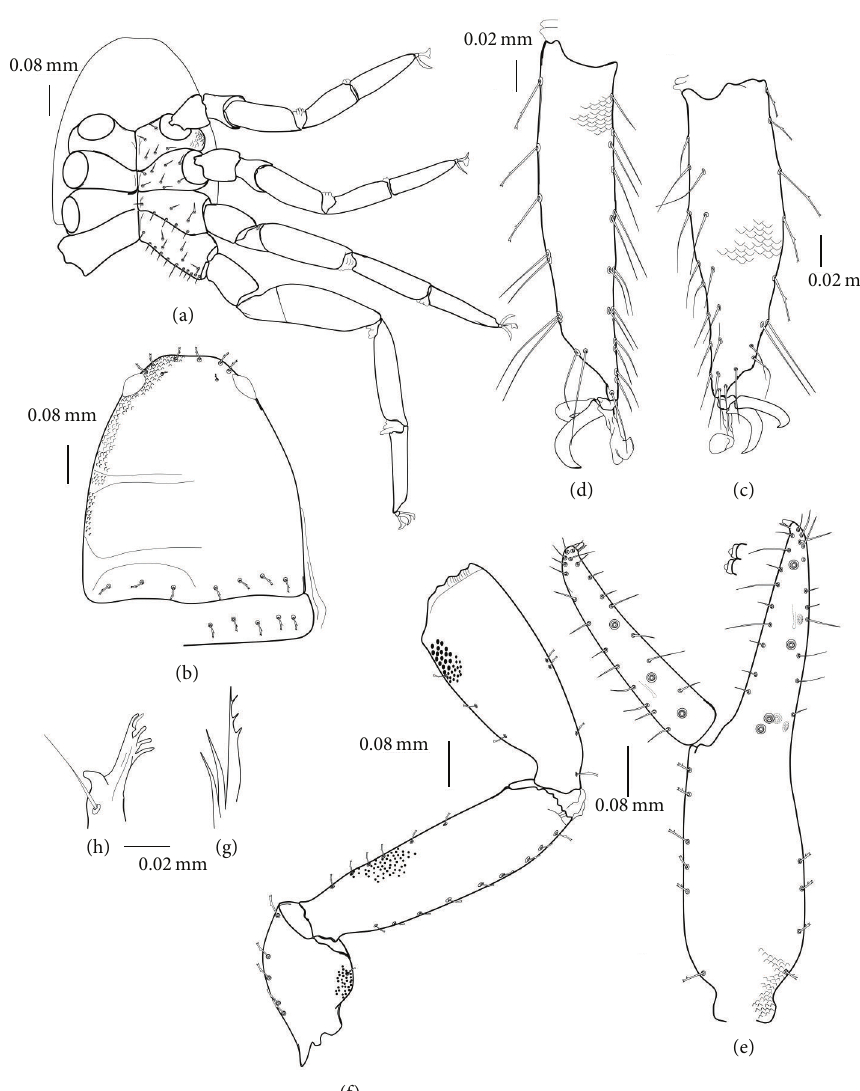
Figure 5: Tritonymph: (a) legs and ventral view of carapace, (b) dorsal side of carapace, (c) tarsus of leg I, (d) tarsus of leg IV, (e) left chela, (f) pedipalp, (g) rallum, and (h)